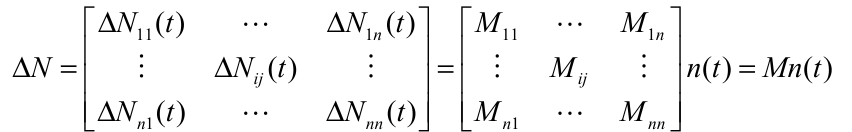
, intrinsic fluctuation Δ N ij